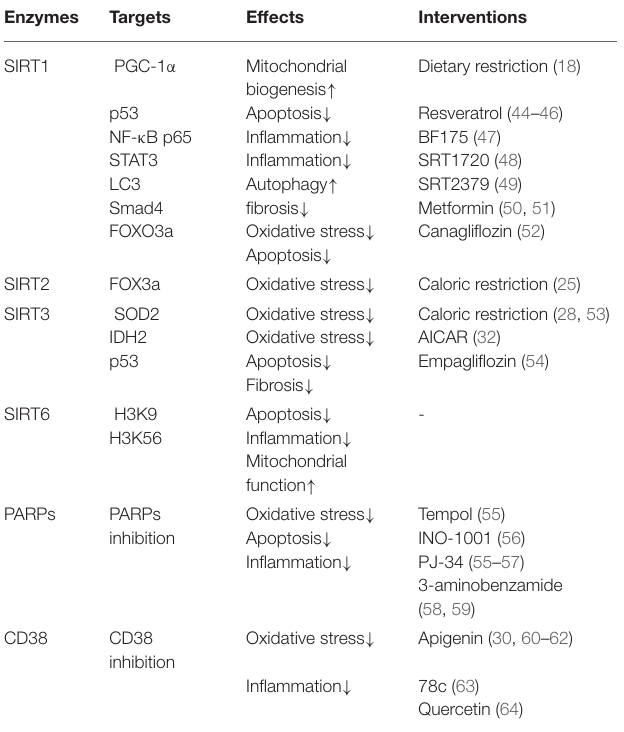
TABLE 1 | Deacetylated targets of NAD + -consuming enzymes in DKD. Enzymes